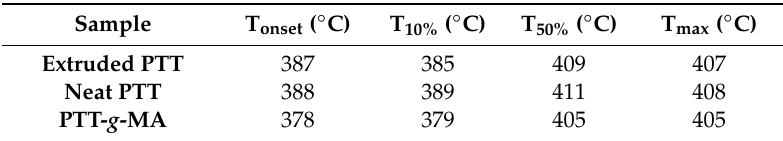
Table 2. Initial thermal degradation temperature (T onset ), temperatures at weight loss of 10% and50%, and maximum weight loss rate temperature (T max